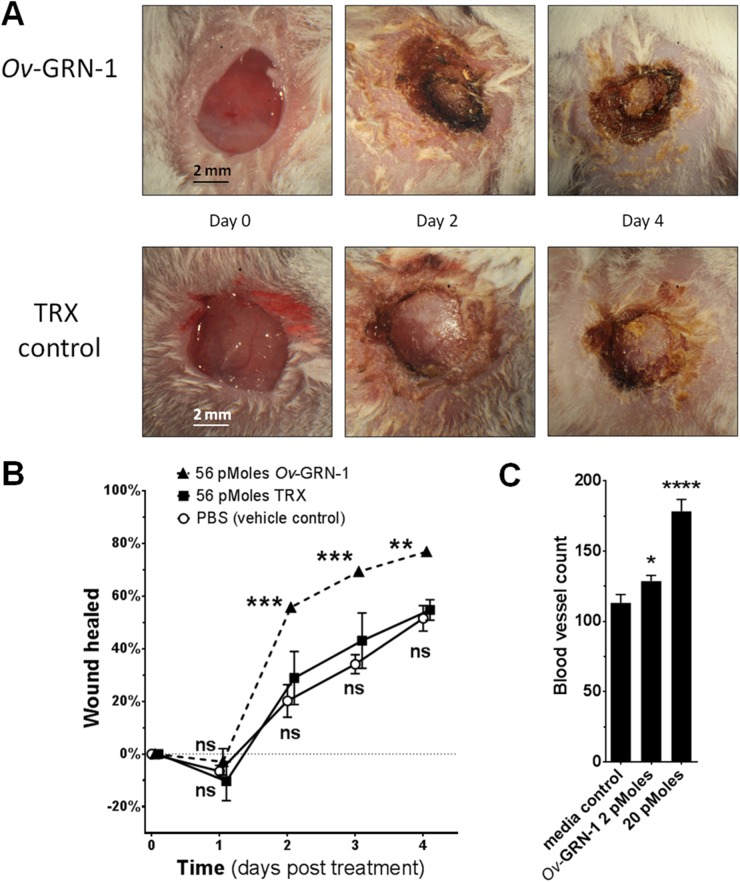

Ov-GRN-1 stimulated wound repair in vivo.
(A) Sequential images over four days of healing wounds revealed the response of mice to treatment with recombinant rOv-GRN-1 or rTRX control; skin-deep wounds made with a 5 mm diameter biopsy punch between the ears of Balb/c mice. Minor modifications (brightness, contrast, cropping) were made to aid viewing. (B) The rate of wound healing over four days was measured; wound closure was determined electronically from photographs by measuring wound areas with ImageJ software. To aid viewing, curves have been shifted left or right marginally to minimize error bar overlap. (C) Assessment of the angiogenic properties of recombinant Ov-GRN-1 in the chorioallantoic membrane (CAM) assay. The numbers of blood vessels in quail eggs that grew on 0.5 cm2 filter paper soaked in rOv-GRN-1 or vehicle (control) were ascertained after incubation for 15 hours. Data points are the averages of two experiments with 3–5 biological replicates displayed with SEM bars. * = P<0.05, ** = P<0.01, *** = P<0.001, **** = P<0.0001, ns = not significant.